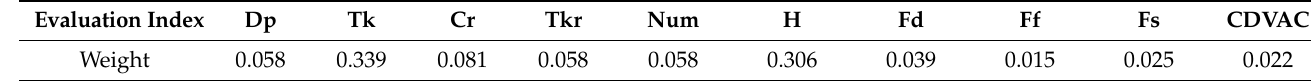
Table 4. Comprehensive weight based on the AHP-CRITIC